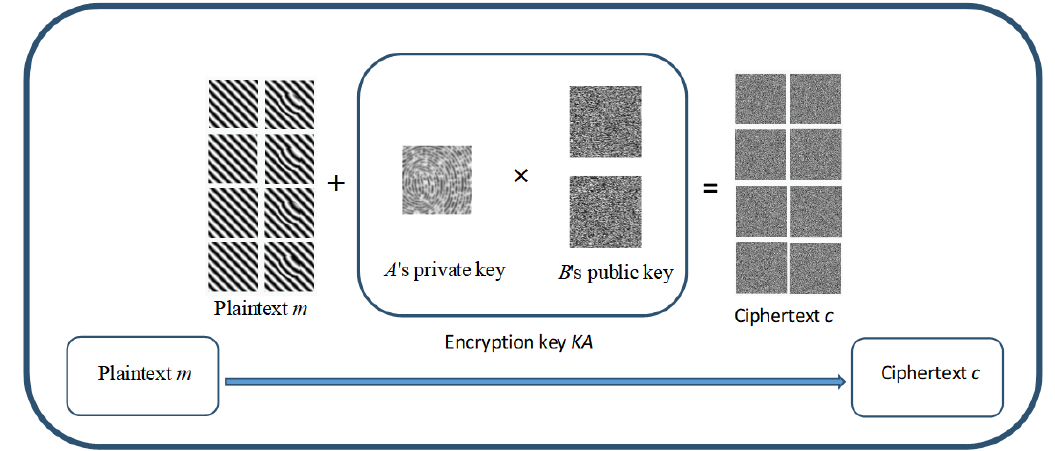
Figure 2. Elliptic curve encryption flow chart.